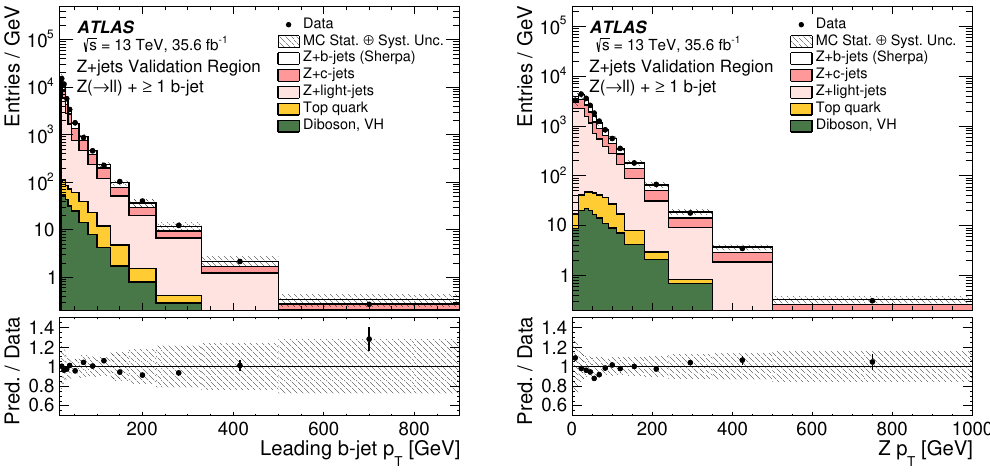
Figure 3 . The p T of the leading b -jet (left) and of the Z boson (right) for events with at least one b -jet in the Z +jets validation region de(cid:12)ned in table 3. Post-(cid:12)t distributions for signal and Z + jets backgrounds are shown. Systematic and statistical uncertainties for the predicted distributions are combined in the hatched band, and the statistical uncertainty is shown on the data points. The uncertainty in the predictions includes only the (cid:13)avour-tagging e(cid:14)ciency uncertainty and (cid:13)avour-(cid:12)t